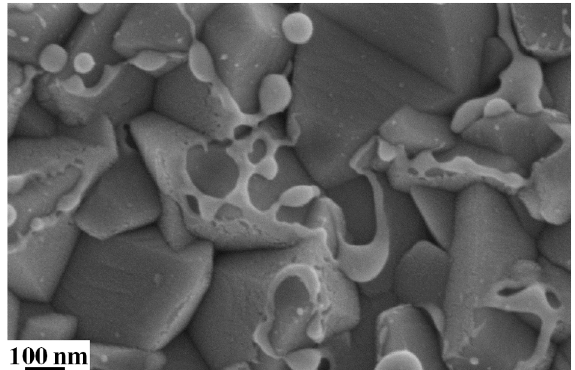
Figure 6. Enlarged SEM image acquired in on of the spots shown in Figure 5a: the dewetting process is clear by the formation of the spherical nanoparticles from filaments originating from the retreating AuPd film.